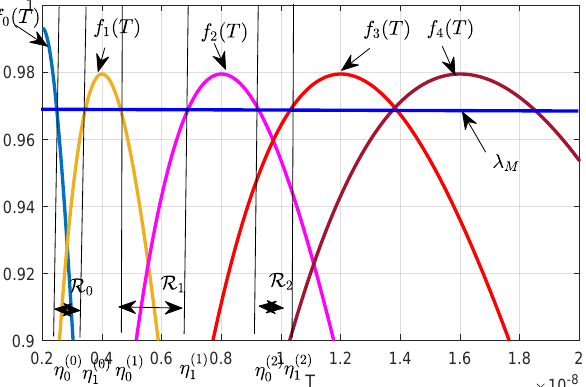
Figure 3. The decision field of AaN detector ( P a = 1 W ), which is divided into N + 1 small intervals due to the existence of multiple normal power